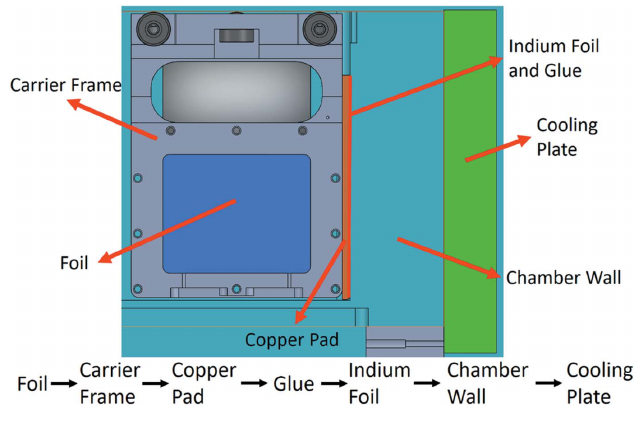
Figure 10 The thermal transfer path from the foil to the chamber wall.